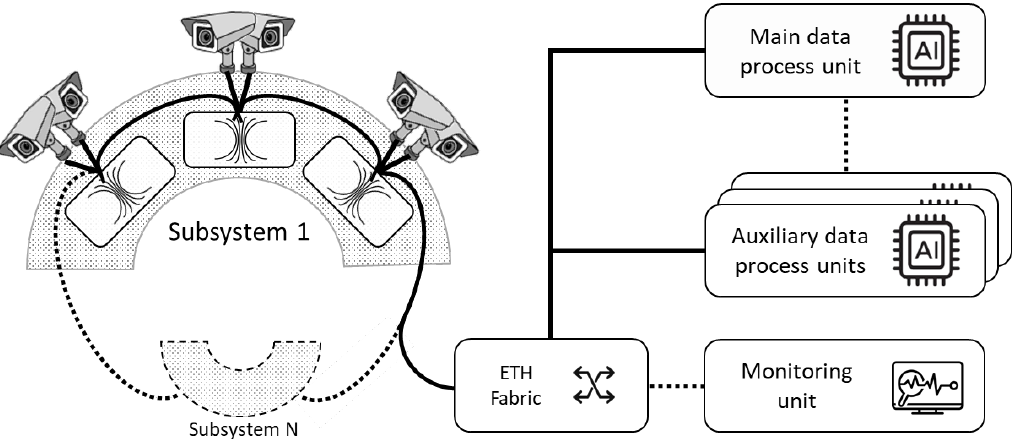
Figure 12. Video-tracking system scheme.